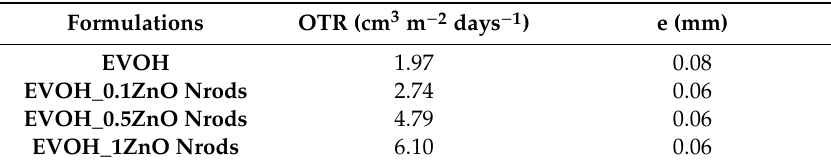
Table 5. Oxygen transmission